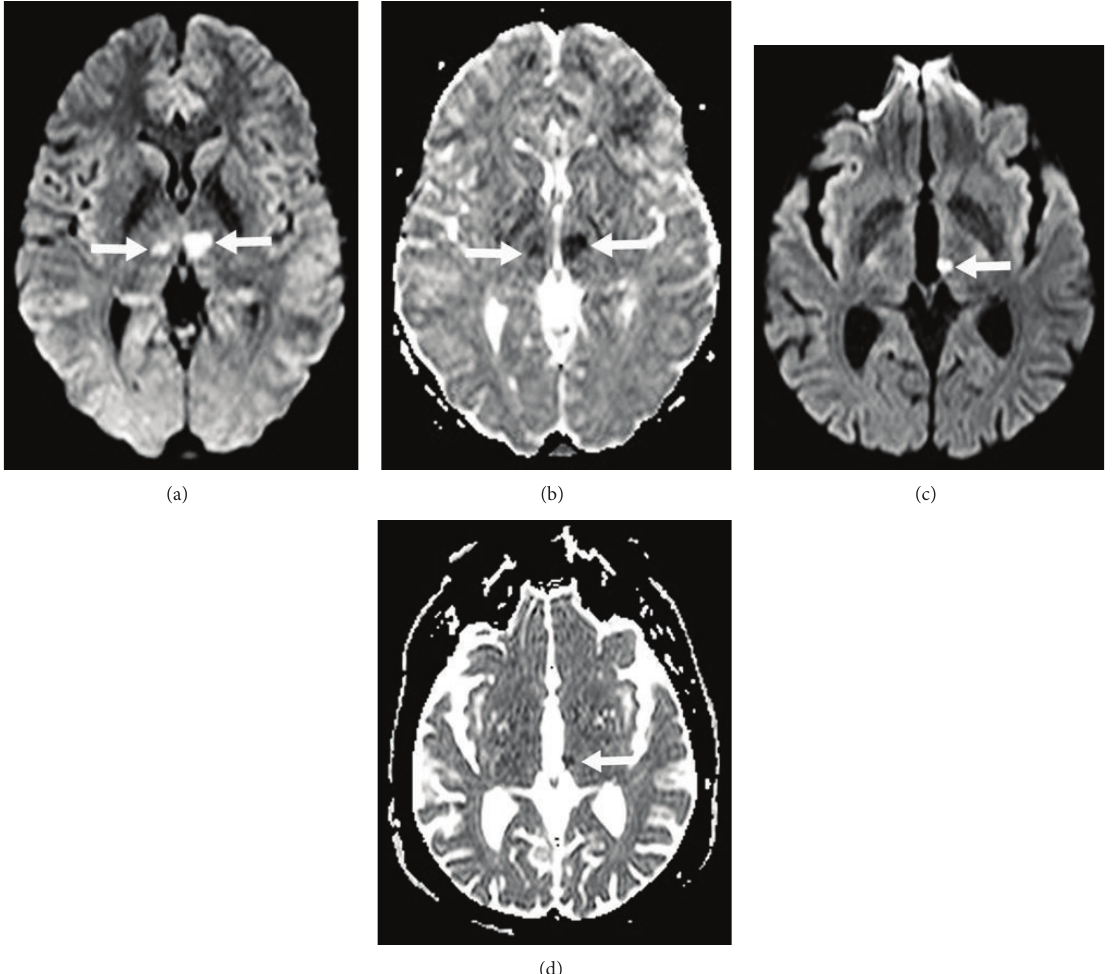
Figure 4: DWI (a and c) and ADC map (b and d) of 2 different patients (patient 1, a and b; patient 2, c and d) showing paramedian anterior thalamic infarction, bilateral in patient 1 and unilateral in patient